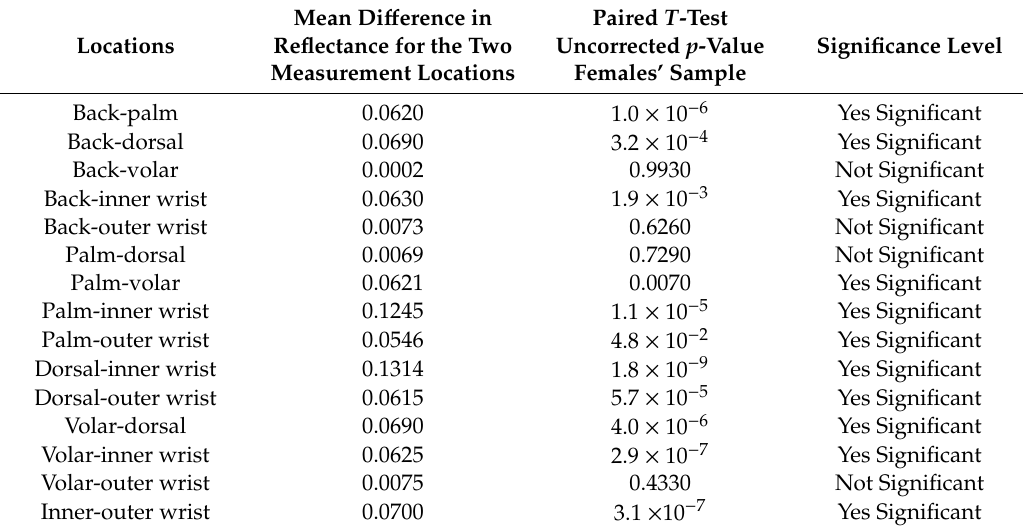
Table 4. Significance level of the mean di ff erences in the reflectance values between all measurements locations of females’ sample.